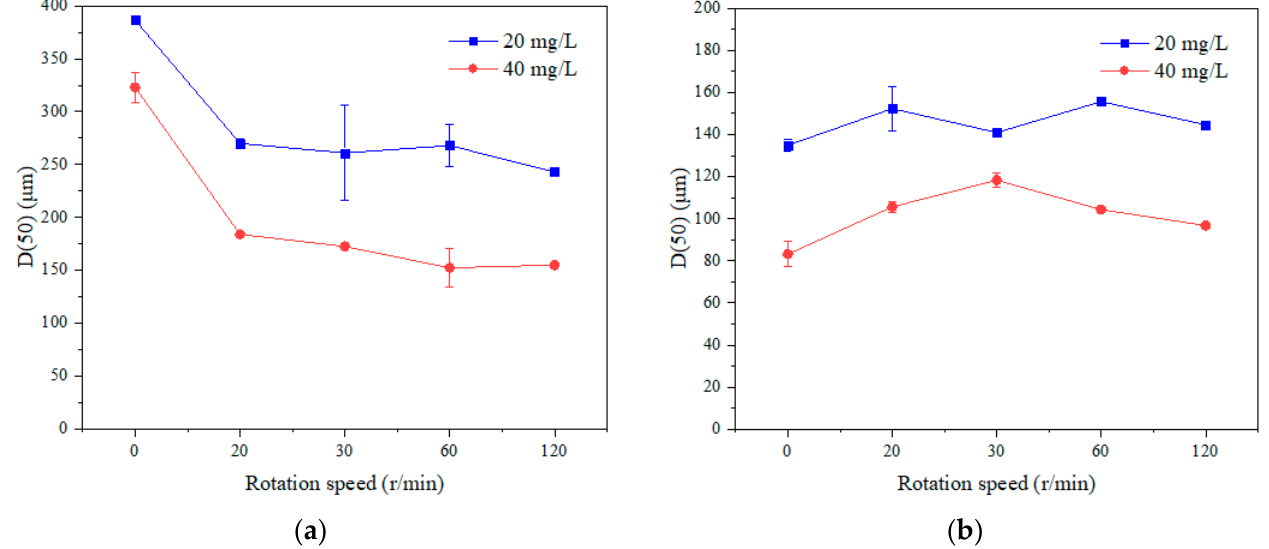
Figure 13. Average particle size of the flocs with different dosages of coagulants and rotation speeds, ( a ) SA, and ( b ) TA.